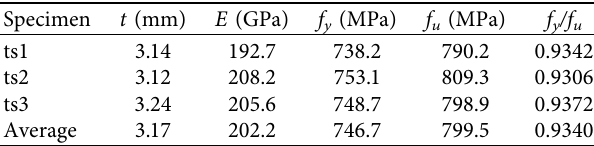
Table 3: Tension coupon test